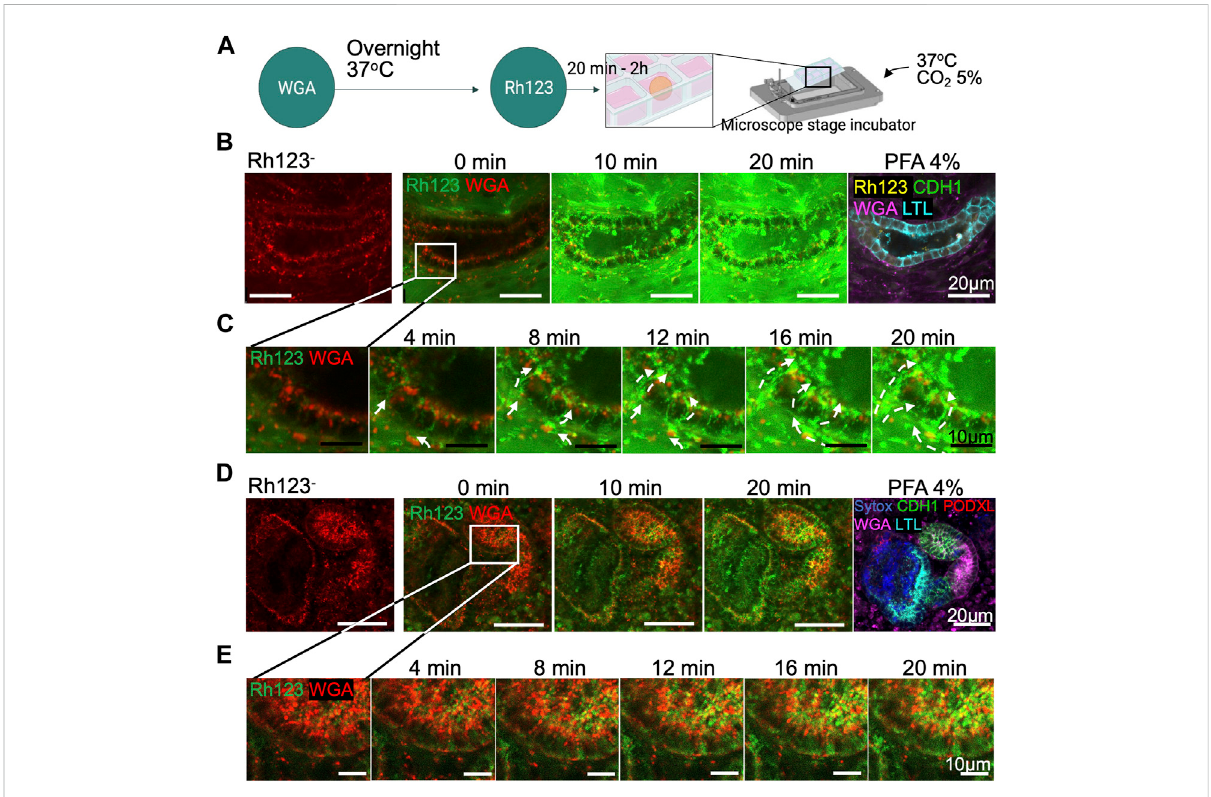
FIGURE 3 Transepithelial transport in live kidney organoids. (A) Protocol for Rh123 assay using the microscope stage incubator. (B) Rh123 transport into tubular lumen after 20 min incubation. The tubular structure was later con fi rmed as an LTL + proximal tubule after organoid PFA fi xation. (C) High magni fi cationimagesdisplayadistinctRh123trans-cellulartransportfromtheinterstitialtoluminalspaceofproximaltubules.Thedashedlinesshow the Rh123 movement, and the arrowhead indicates the transport direction. (D , E) In contrast, tubular structures that transport less Rh123 are CDH1 + distal tubules as con fi rmed by